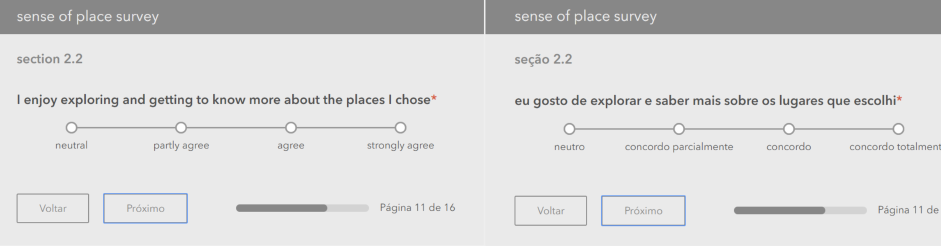
Figure 13: Likert question for place awareness.